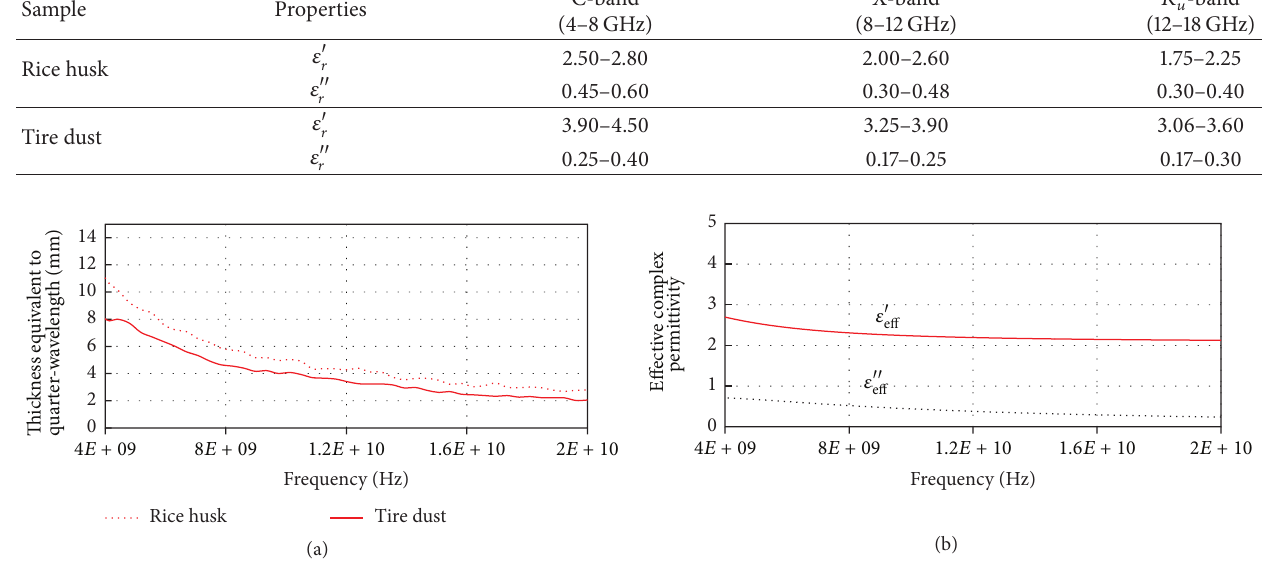
Table 1: Measured range of dielectric properties of the two fabricated samples in different frequency bands. Sample